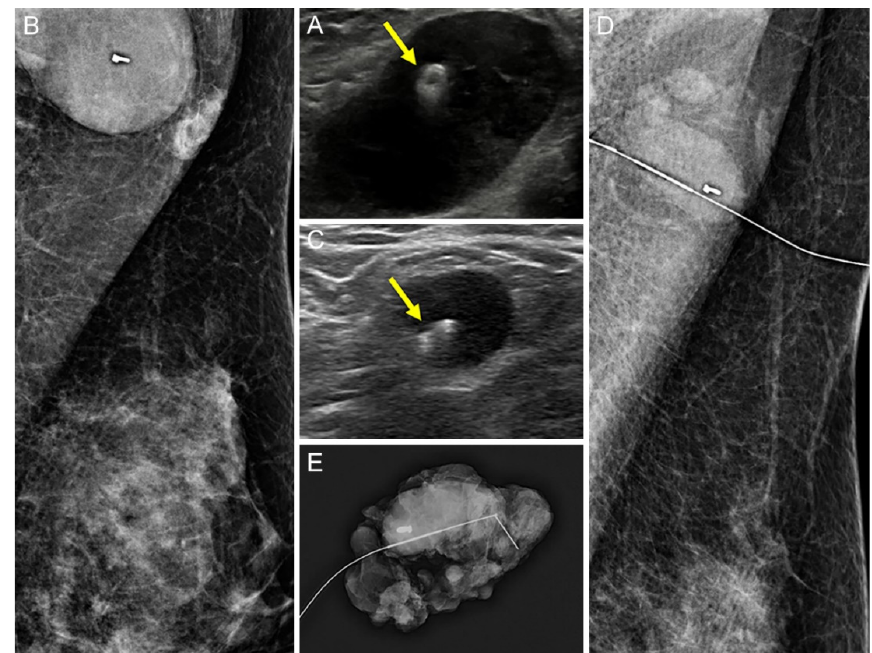
Figure 3. A 37-year-old woman with left breast cancer and ipsilateral axillary metastatic lymph node (LN) underwent UltraCor Twirl insertion before neoadjuvant chemotherapy (NAC). ( A , B ): The clip (arrow) was deployed at the cortex of the histologically proven metastatic LN by ultrasound (US) ( A ), and the location was confirmed by mammography ( B ). ( C – E ): After NAC, the size of the LN decreased, although it remained suspicious on US. The clip (arrow) was also easily identifiable in residual metastatic LN on US ( C ): US-guided wire localization was performed and confirmed by mammography ( D ). The wire was successfully located at the clipped LN and subsequent specimen mammography confirmed the successful retrieval ( E ).